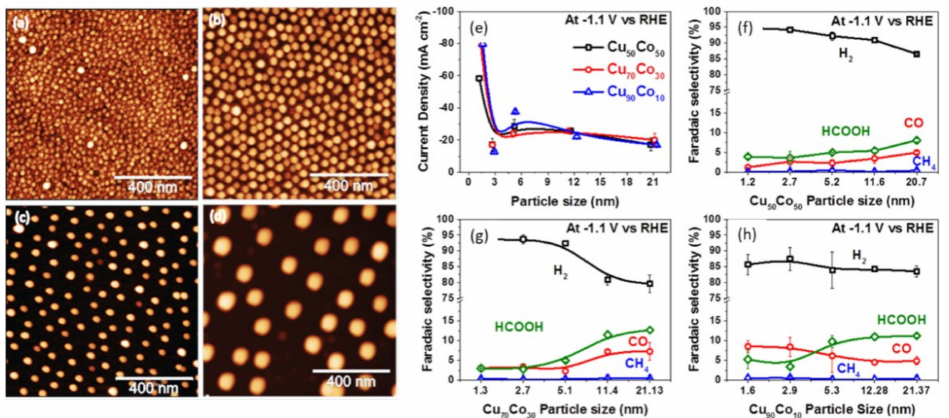
Figure 4. AFM micrographs of Cu50Co50 NPs with different sizes supported on SiO 2 /Si (111). The average NP size: ( a ) 2.7nm (S2), ( b ) 5.2nm (S3), ( c ) 11.6nm (S4), ( d ) 20.7nm (S5). ( e ) Current density as a function of the particles size of CuxCo100-x NPs. Faradaic selectivity as a function of the NP size: ( f ) bimetallic Cu50Co50 complex, ( g ) Cu70Co30 complex, ( h ) Cu90Co10 complex. The data were obtained after 1 h of CO 2 RR at E = − 1.1V vs. RHE. Reproduced from [130], with permission from